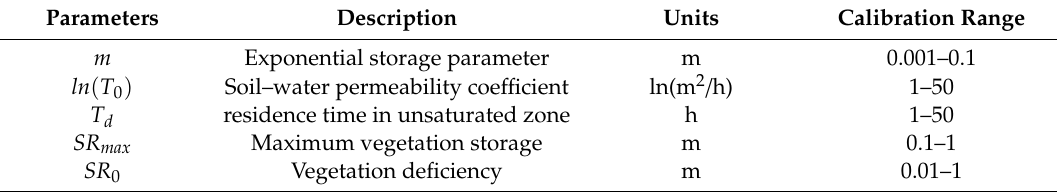
Table 3. Calibration parameters and ranges used in TOPMODEL in this study [32,33].